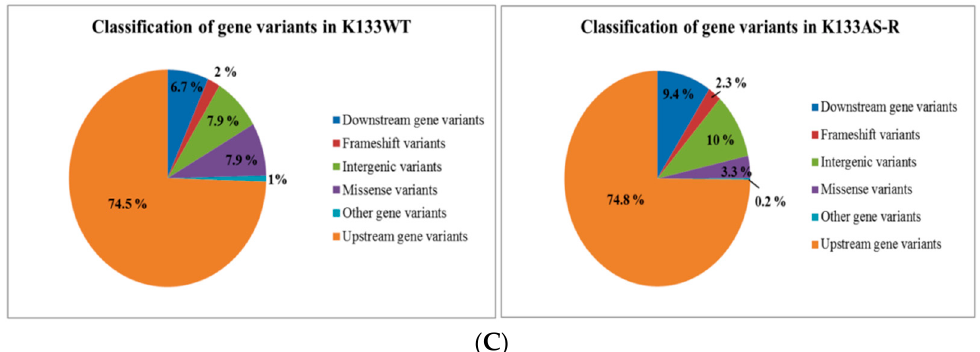
Figure 1. Comparative Analysis of Single Nucleotide Polymorphisms (SNPs) present in K133AS-R with K133WT. ( A ) Venn diagram showing the unique genes present in K133WT and K133AS-R. ( B ) Comparative SNP density analysis of K133WT vs. K133AS-R ( C ) Pie chart showing the percentage of different gene variants present in K133WT and K133AS-R.